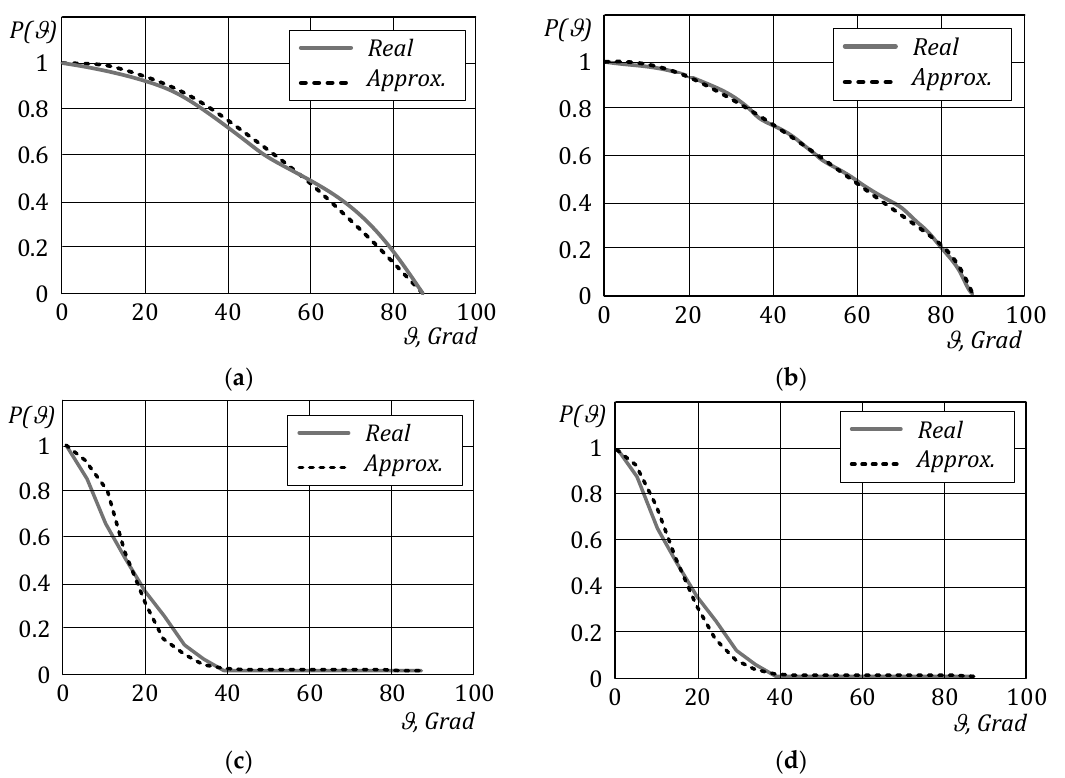
Figure 6. Approximation of the radiation diagrams: ( a , b ) IR LED C3535SIRC; ( c , d ) IR LED 53F7C, respectively with Functions (4) and (8).